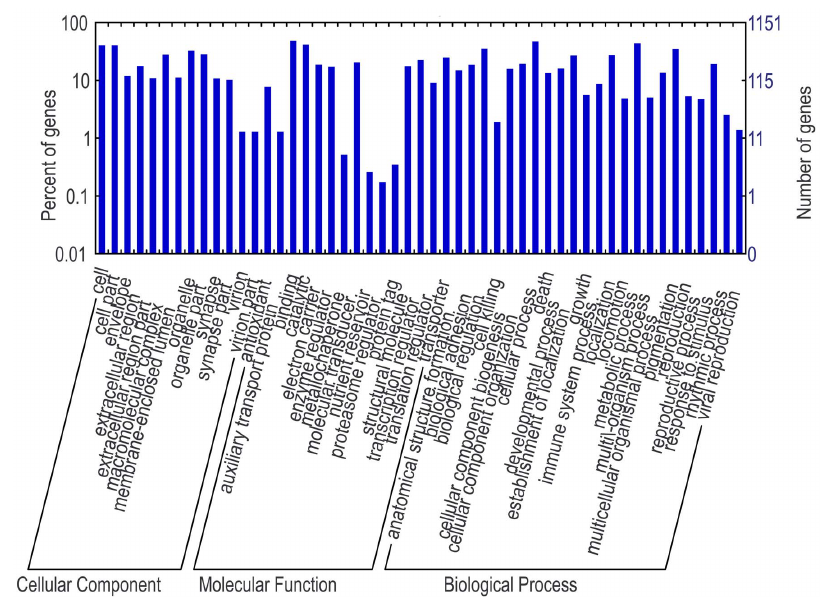
Figure 5. GO terms for predicted target genes.